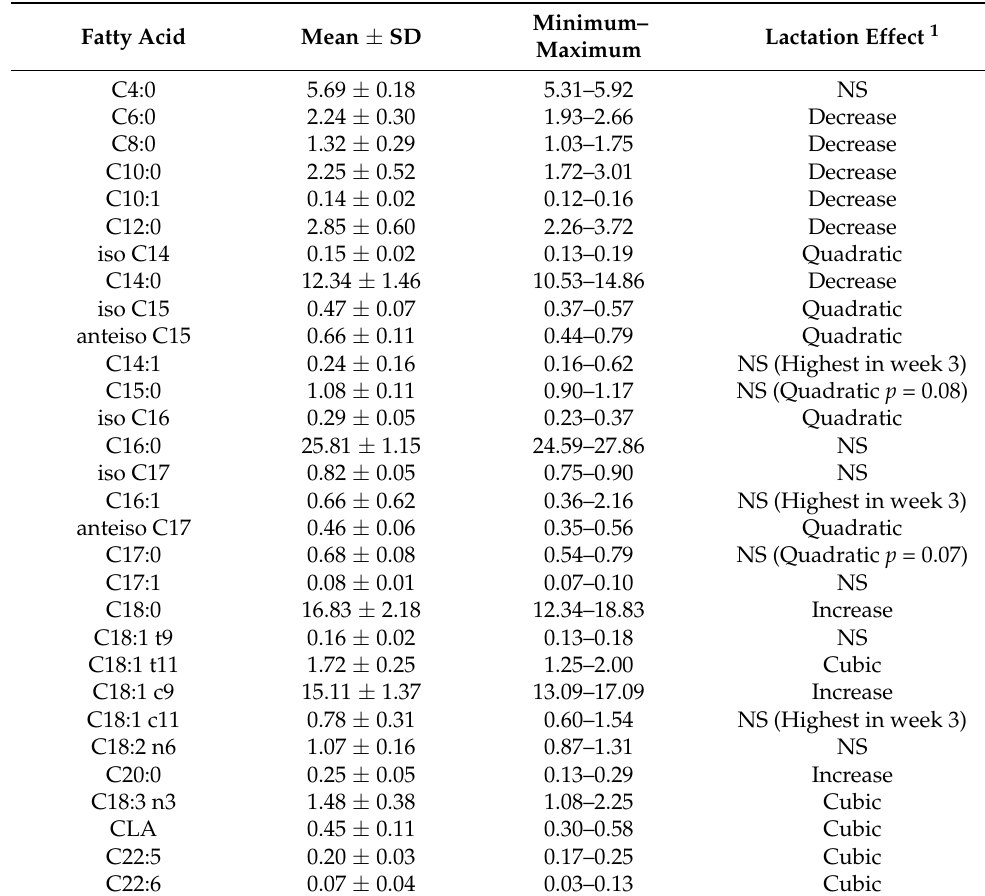
Table 2. Fatty acid composition (g fatty acid/100 g) of deer